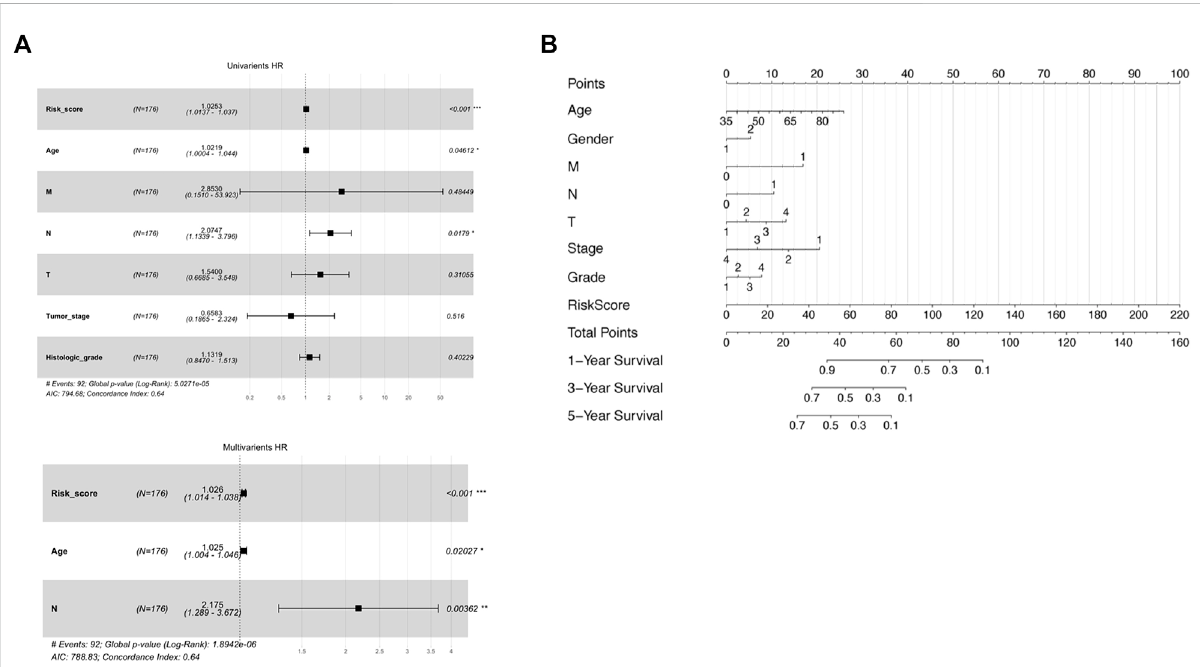
FIGURE 4 Assessmentofprognosticabilityofbothseparateandcombinedusageofriskscoreandclinicalfactors. (A) Uni-andmultivariateCoxregression by risk score and other clinical factors as OS predictor. (B) Nomogram including risk score determined by the lncRNA-based signature and other clinical factors for OS prognostic